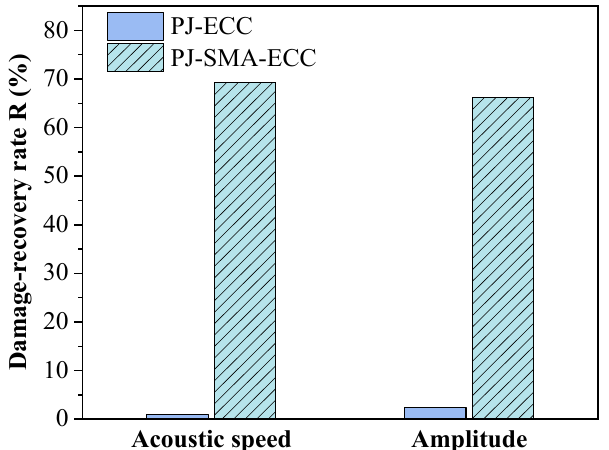
Figure 18. The comparison of the damage-recovery rate.